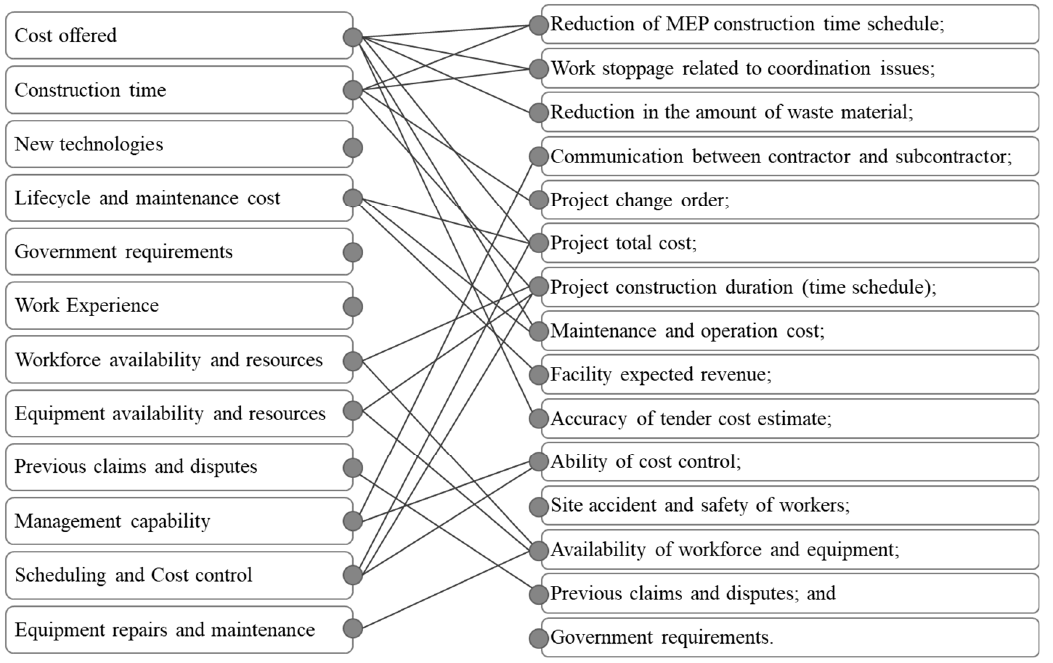
Figure 6. Mapping between BIM advantages and TSC.